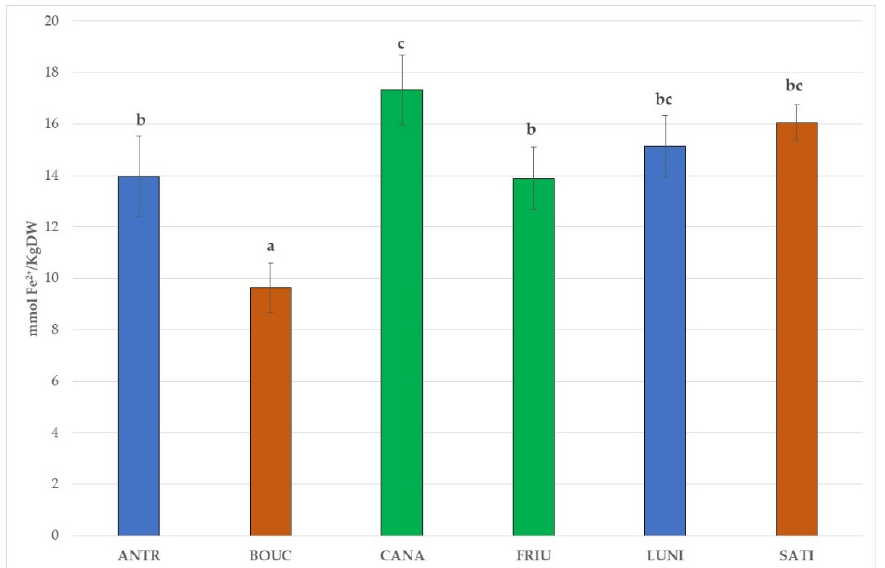
Figure 1. Total polyphenolic content of the analysed chestnut flours. Different letters for each flour indicate the significant differences at p < 0.05. Blue colour: commercial flours from Lazio (ANTR) and Toscana (LUNI); orange colour: flours from Piemonte; green colour: flours from Friuli-Venezia Giulia.